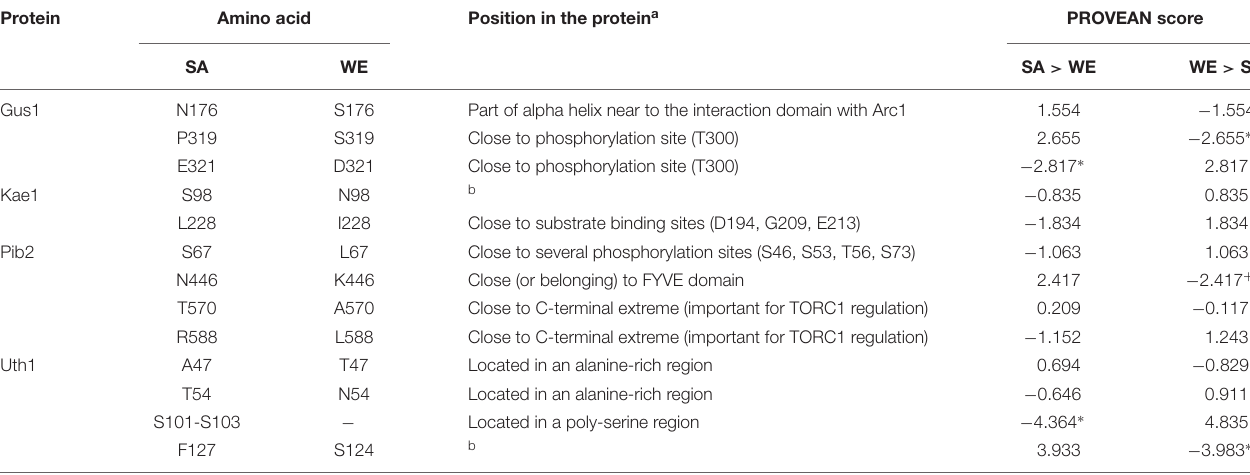
TABLE 4 | Analysis of the non-synonymous polymorphic sites in the validated genes. Protein Amino acid Position in the protein a PROVEAN score